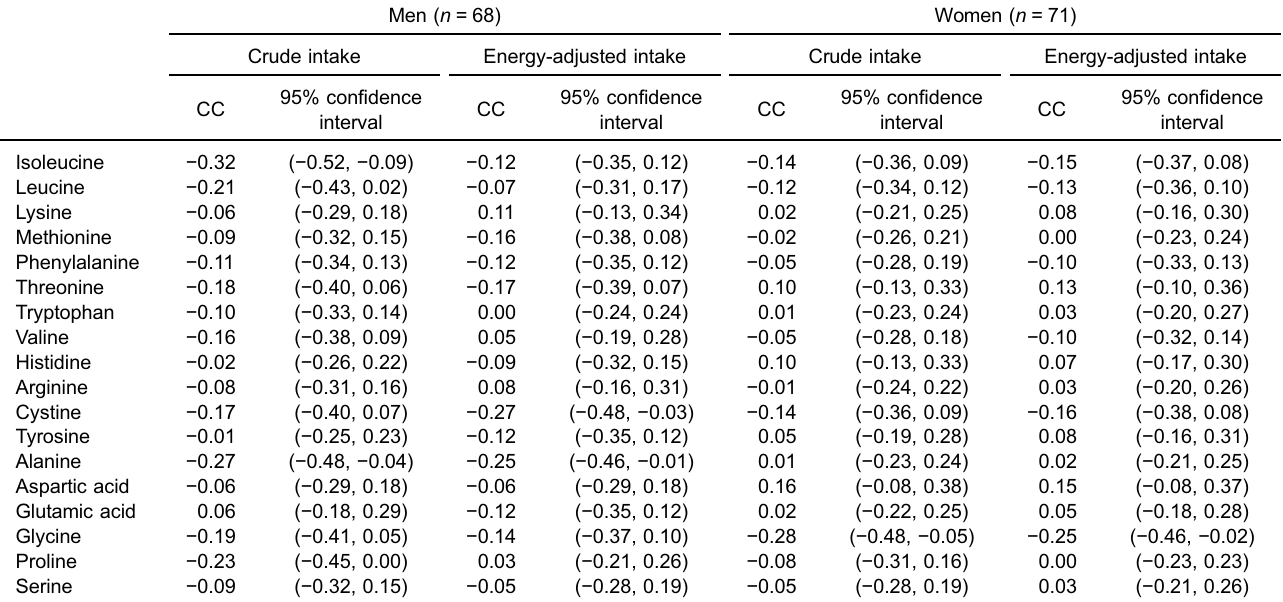
Table 5. Spearman rank correlation coef fi cients of amino acid intake from a food frequency questionnaire and plasma amino acid